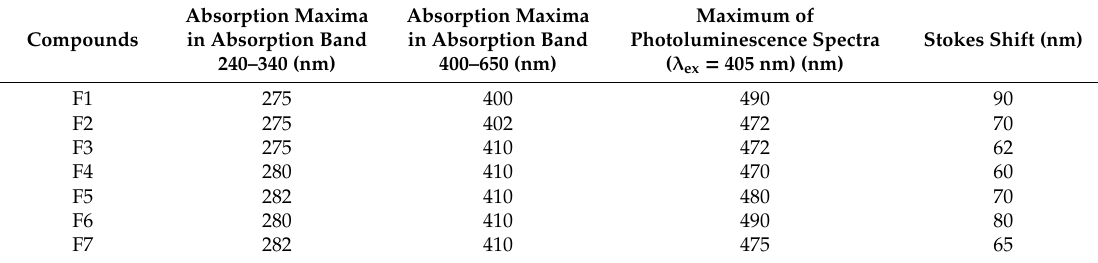
Table 4. Maxima of absorption and photoluminescence spectra of the investigated materials F1–F7 (λ ex —laser excitation wavelength).